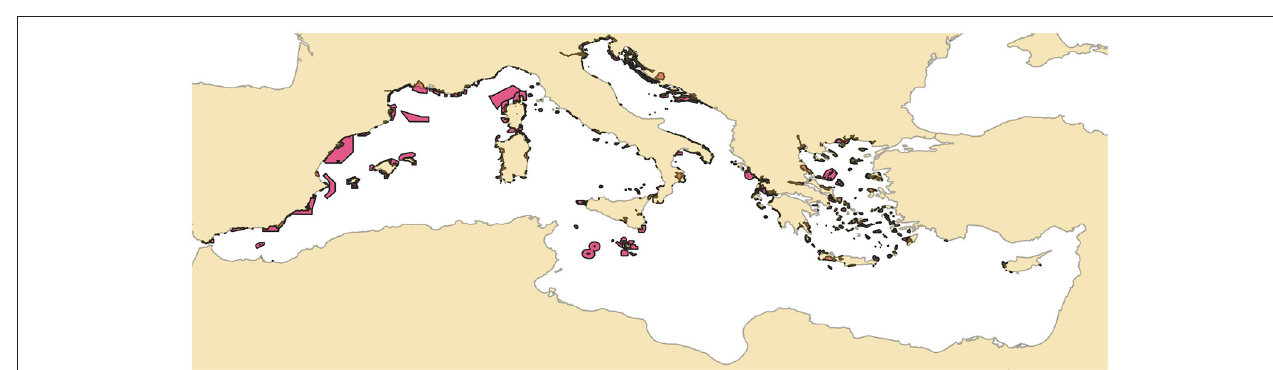
FIGURE 5 | Mediterranean Natura2000 sites indicated by purple. Data provided by MAPAMED (2020).